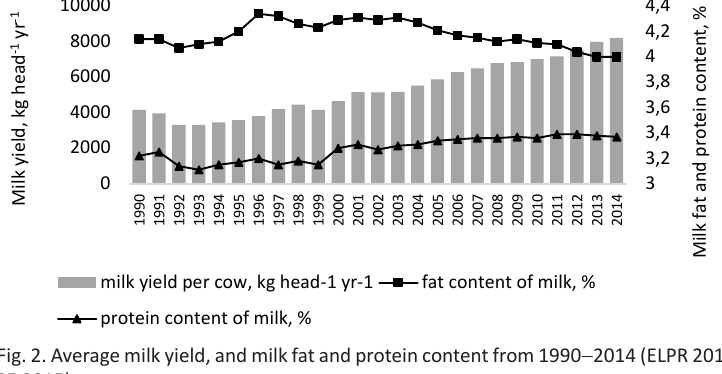
Fig. 2. Average milk yield, and milk fat and protein content from 1990 − 2014 (ELPR 2015,